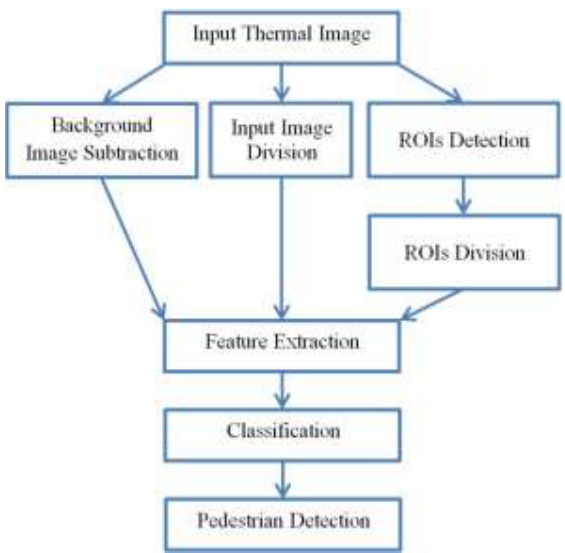
Figure 2. Main sections of recent approaches for pedestrian detection in thermal